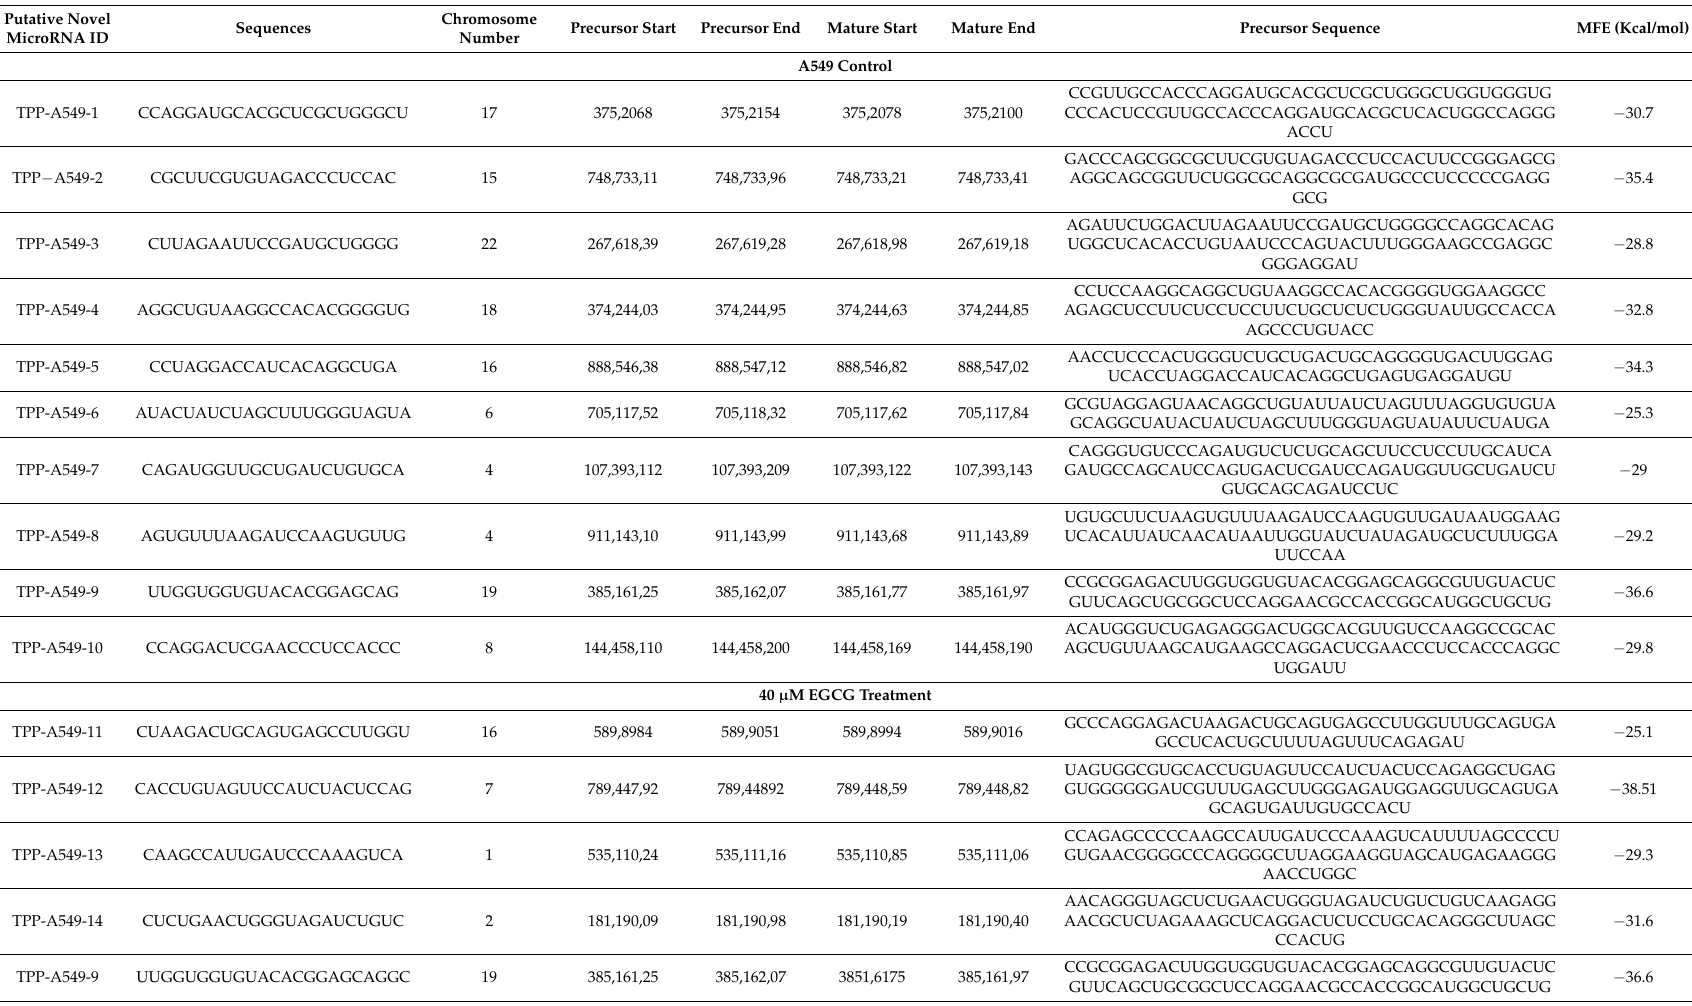
Table 1. Top 10 putative microRNA sequences expressed in the untreated control, 40, and 100 µ M EGCG